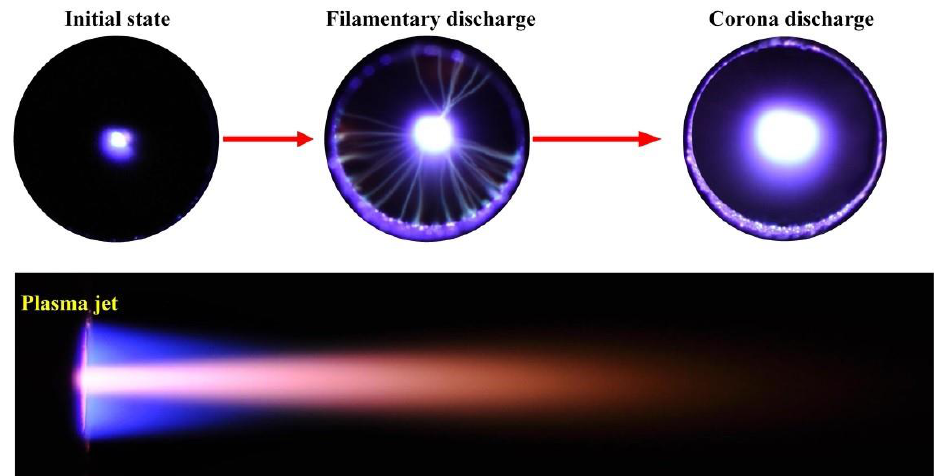
Figure 2. Discharge process and stable plasma jet under U = 1.53 kV.